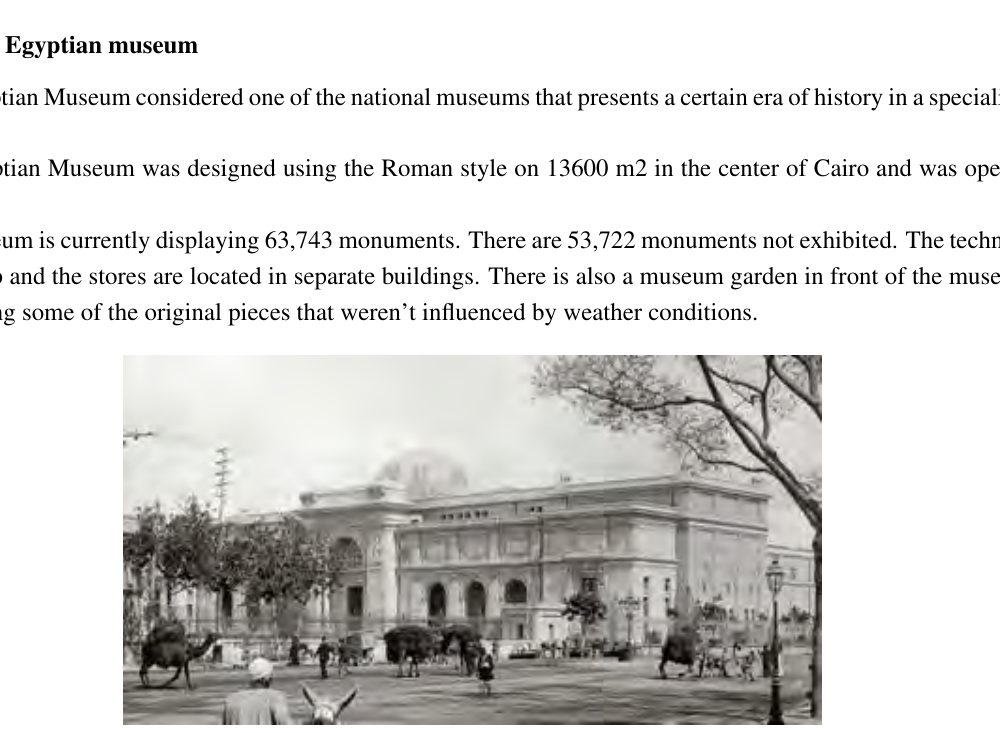
Figure 3. The Egyptian museum Cairo Museum, early 1900s Photo by: The American Colony and Eric Matson